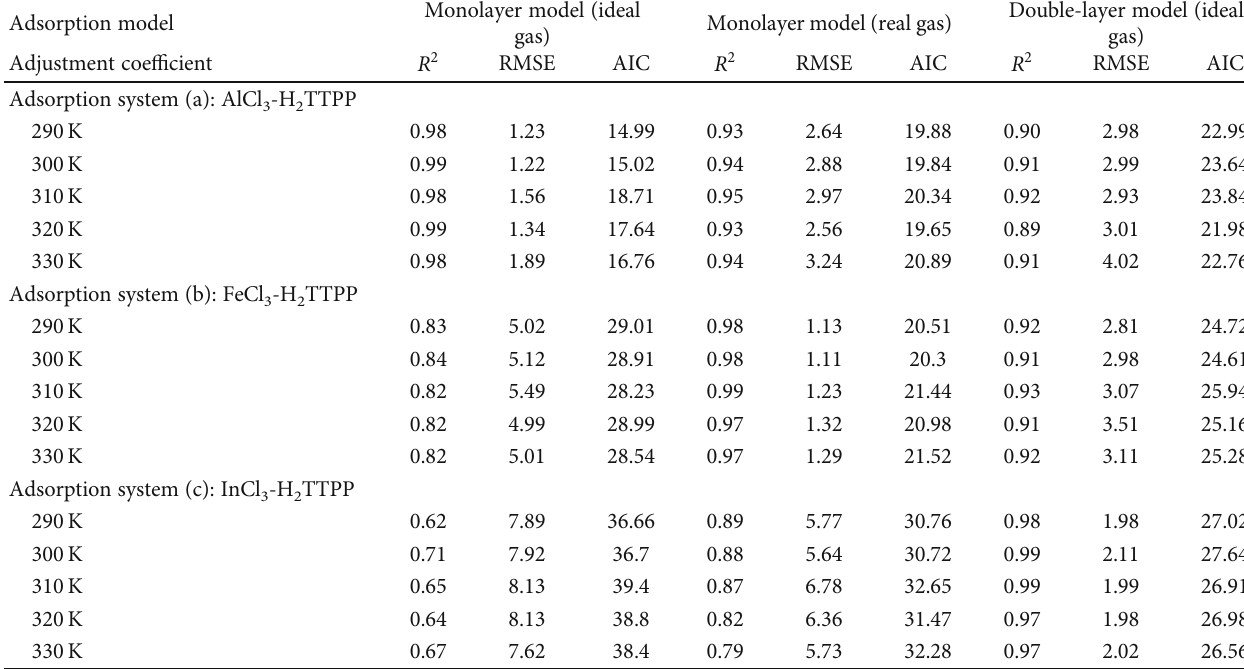
Table 2: Values of the error fi tting coe ffi cients R 2 , RMSE, and AIC deduced from the numerical adjustment of experimental data of AlCl